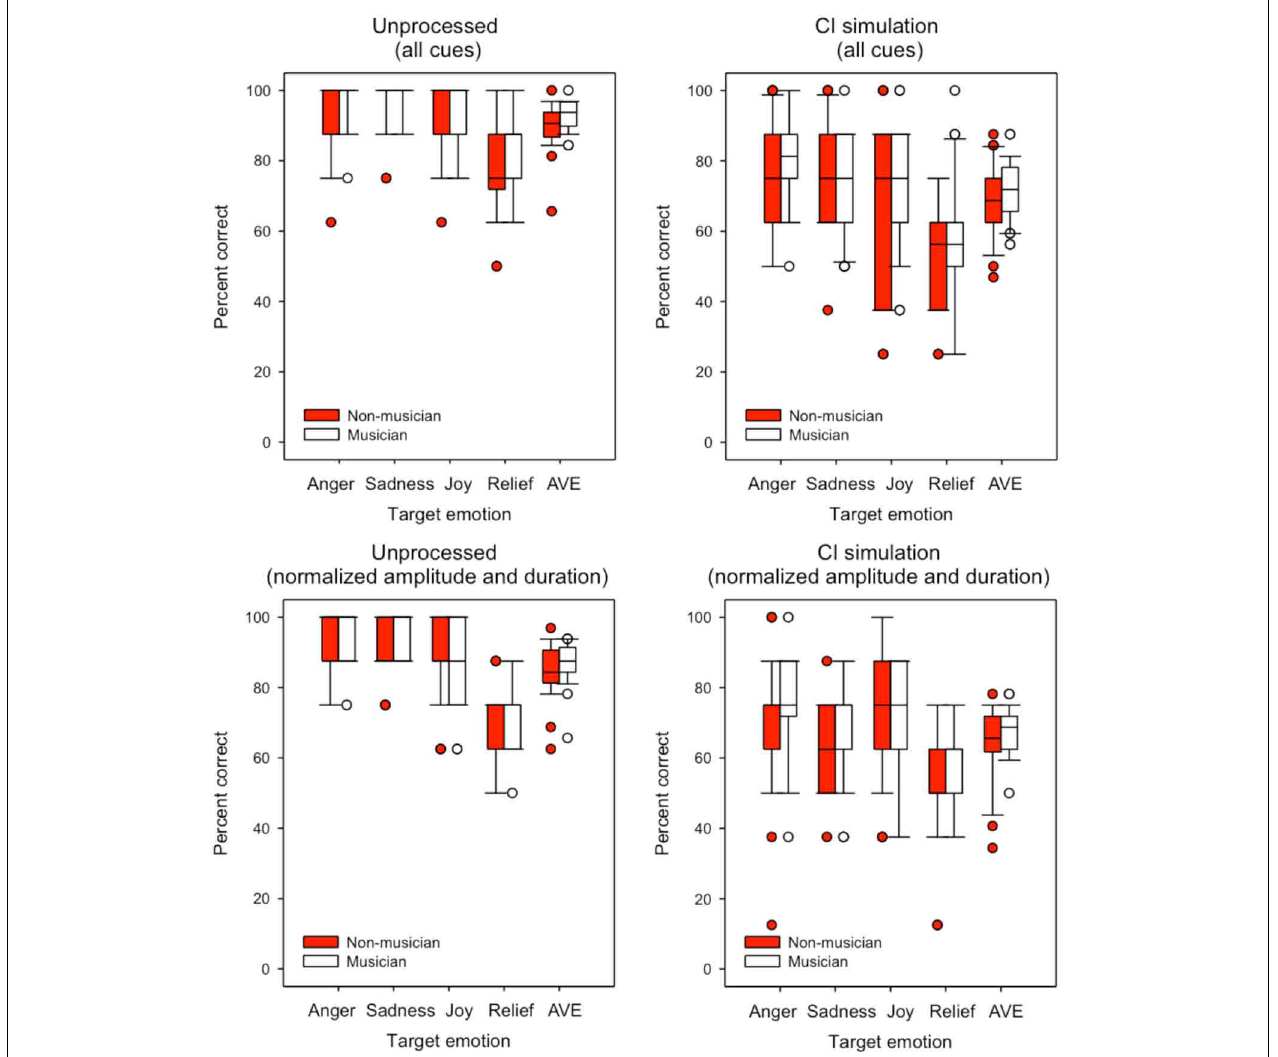
FIGURE 6 | Boxplots for identification of each emotion and overall emotion identification for musicians and non-musicians. The left and right panels show data with unprocessed stimuli or with the CI simulation, respectively. The top panels show